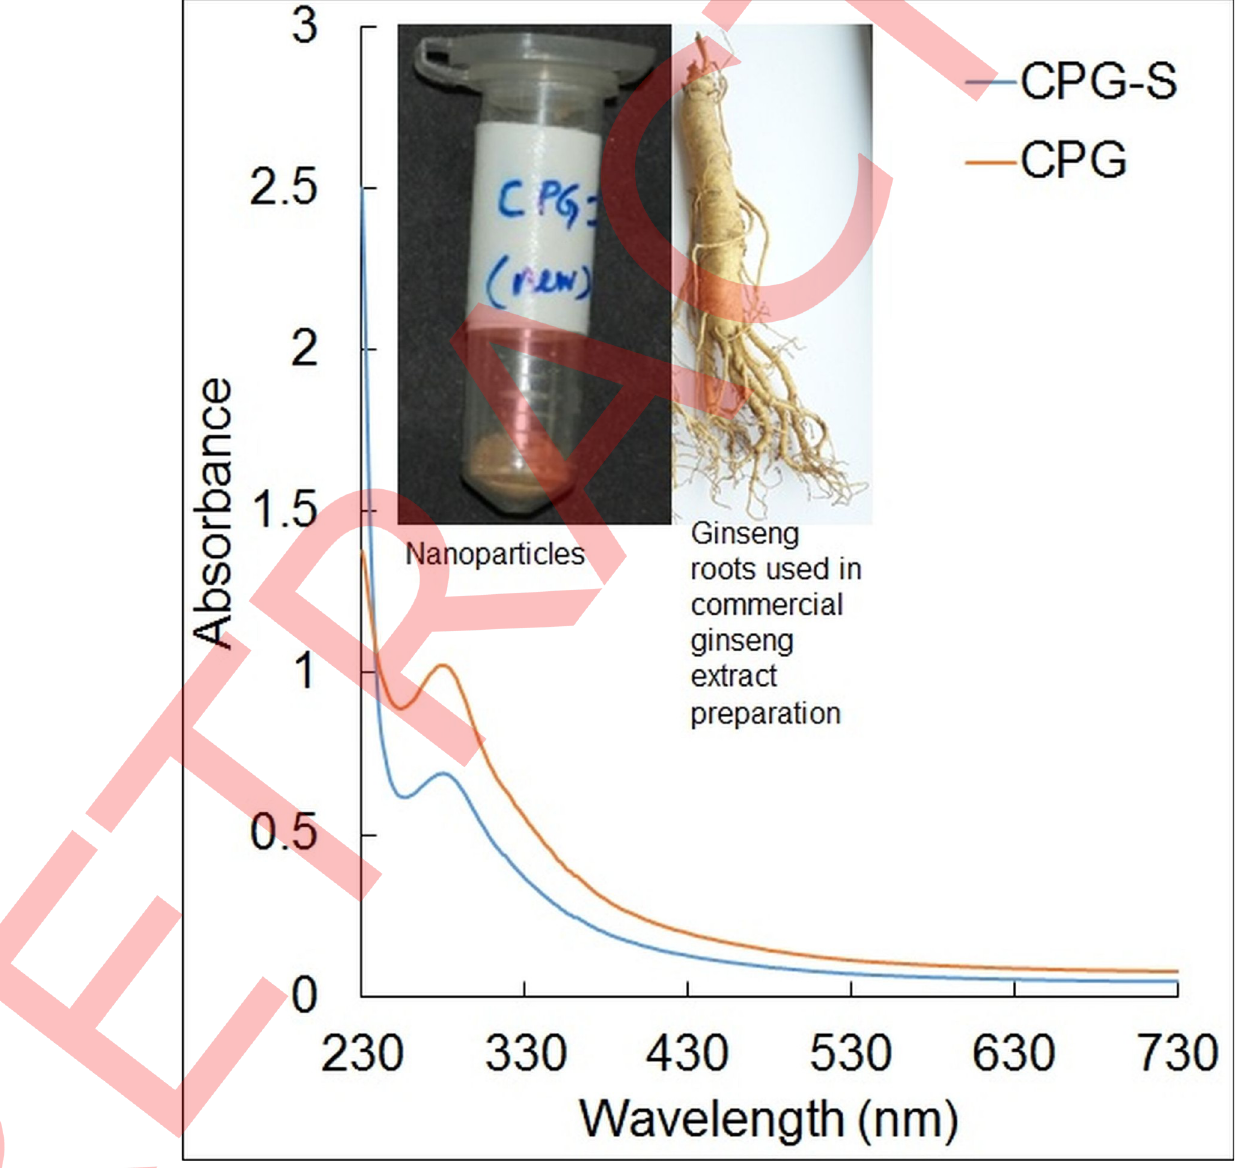
Fig 1. UV-VIS spectra of the synthesized CPG-S NPs. (Inset: Red ginseng extract used as reducing agent in the synthesis of NPs and the synthesized CPG-S NPs). https://doi.org/10.1371/journal.pone.0217318.g001 PLOS ONE | https://doi.org/10.1371/journal.pone.0217318 June 10,